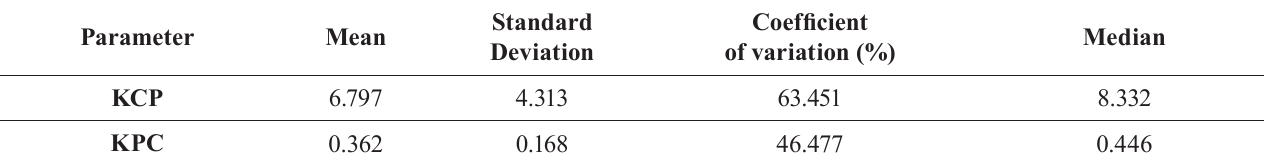
TABLE II - PK population Parameter estimates for vancomycin